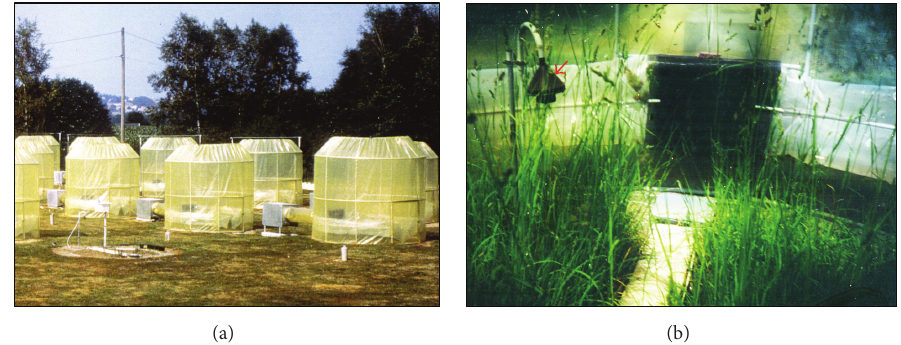
Figure 1: (a) Open-top chambers (OTCs) were located at Montardon site (10km north of Pau, France). Technical characteristics of OTCs, close to those described by Heagle et al. [32, 33], have been already reported [34]. Each circular OTC had a diameter of 3 m and an open-top diameter of 2 m and was 2.8 m tall. It consisted of a galvanised iron frame covered with a polyethylene foil (Deltatex T2E). Ozone-free air (filtered air) or O 3 -enriched air was blown all around the chamber above the canopy level. The flow rate was controlled to achieve an air exchange rate of 3.14 times per min at the canopy level. When supplied, extra ozone was generated by electrical discharge of pure oxygen and injected into the air stream. Extra ozone was equally released only from 10 a.m. to 5 p.m. (GMT) in order to simulate the normal period of ozone exposure. The control chamber received filtered air (before ambient air was blown in the chamber, it passed through a charcoal filter that removed almost totally ozone), while, in O 3 -enriched OTC, O 3 concentration reached 100 𝜇 g/m 3 . Ozone was sequentially monitored in the three OTCs with an UV ozone analyser (Environnement SA, O 3 41M) under the control of a computer recording system. (b) Inside a filtered air chamber: in the foreground mature Dactylis glomerata plants with inflorescences can be seen. The air suction device of the OTC allowing measurement of the ozone concentration is noted with a red